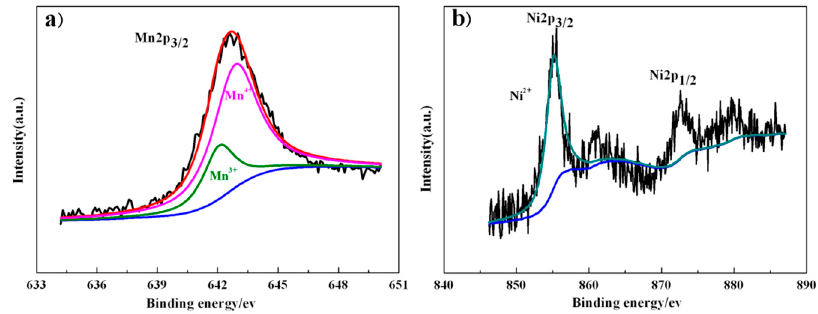
Figure 6. X-ray photoelectron spectra of ( a ) Mn 2p and ( b ) Ni 2p of S 12 .